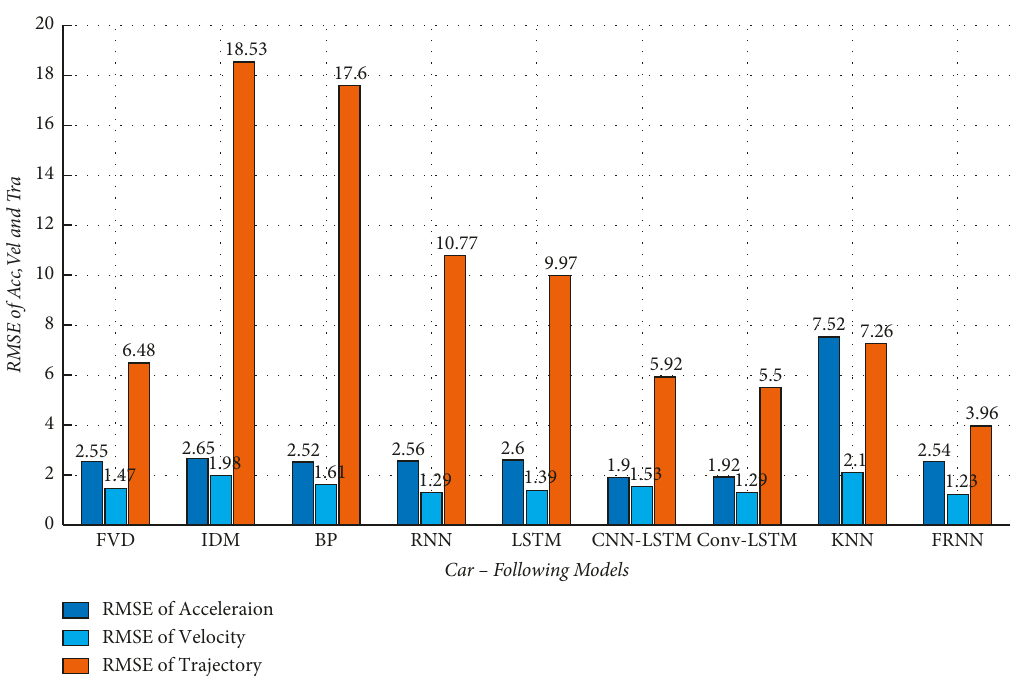
Figure 13: RMSE of conventional models and data-driven models in the continuous traffic flow (ANN CF-A).